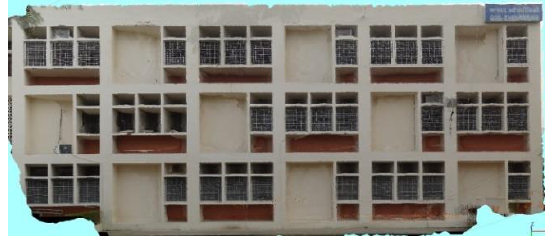
Figure 13: Textured façade model of main building of civil